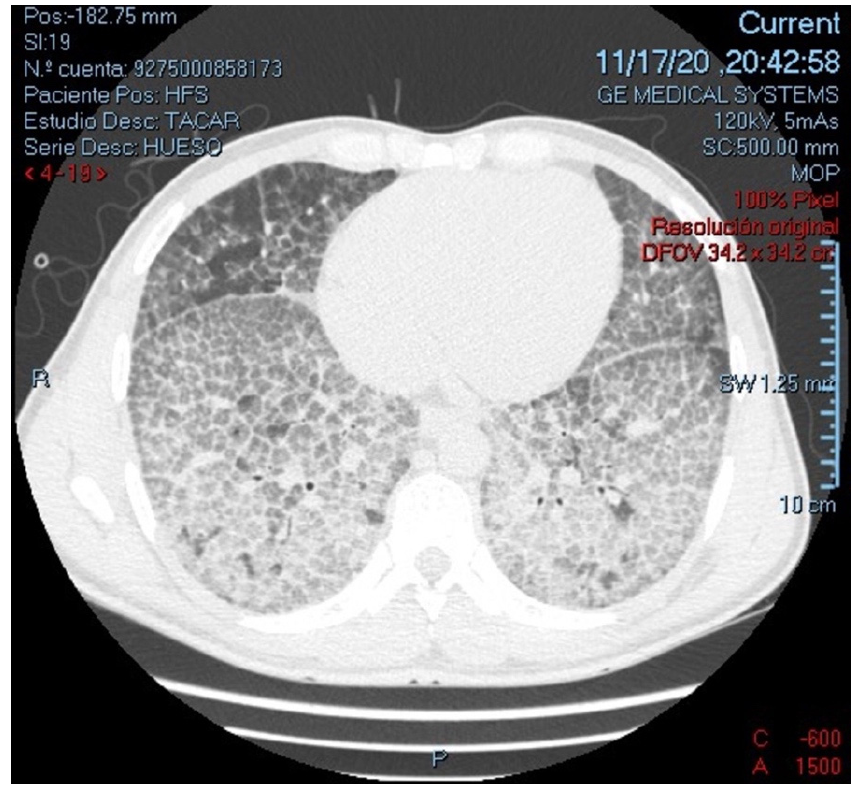
Figure 1. High-resolution computed tomography of the chest (parenchymal view), showing multiple ground-glass opacities with thickening of interlobular septae, configuring an extensive characteristic “Crazy-paving” pattern in both lungs.